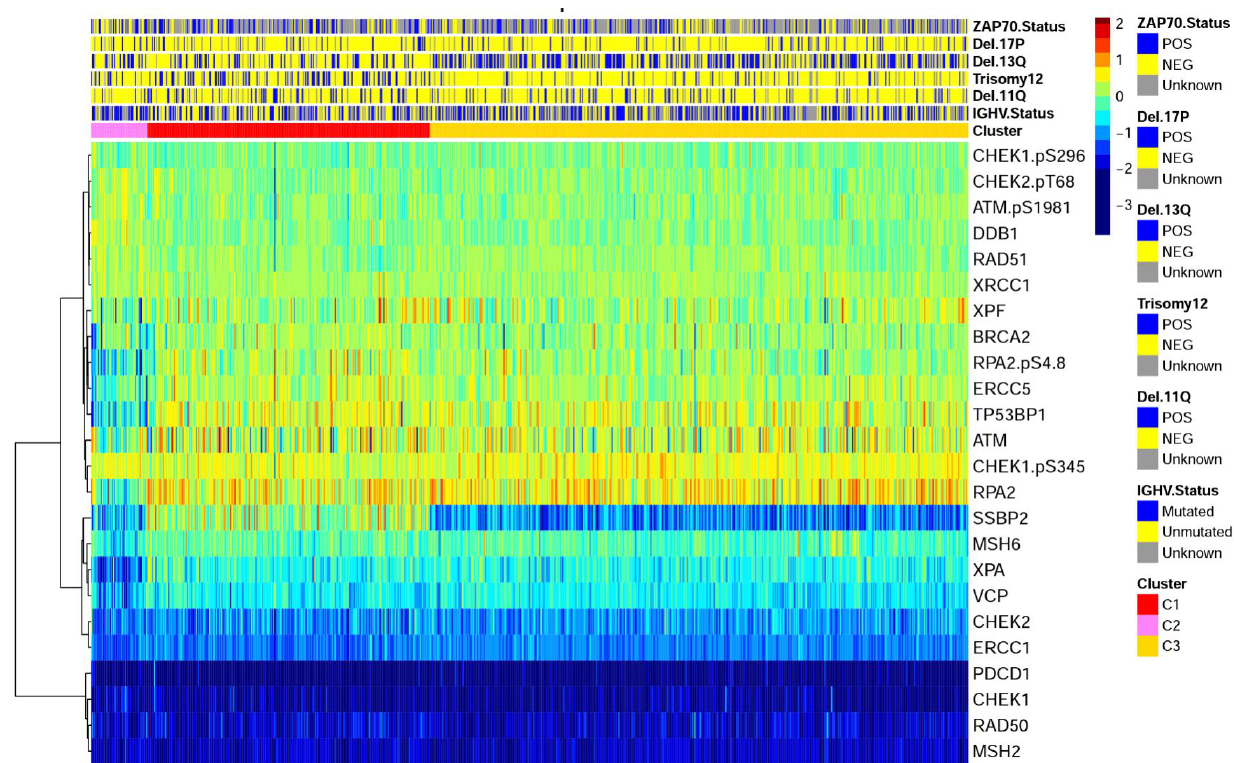
Figure 1. Heatmap of DNA damage protein expression patterns in CLL. CLL patients were clustered based on the range of expression (Log 2 scale, ranging from − 4 to +2) of 24 DNA damage proteins in the RPPA dataset. Patient clusters are shown in the annotation immediately above the heatmap (C1-red, C2-pink, and C3-yellow). Selected recurrent chromosomal abnormalities and IGHV mutation status are shown as annotations above the cluster membership, with blue indicating the presence of that event, and yellow indicating its absence.